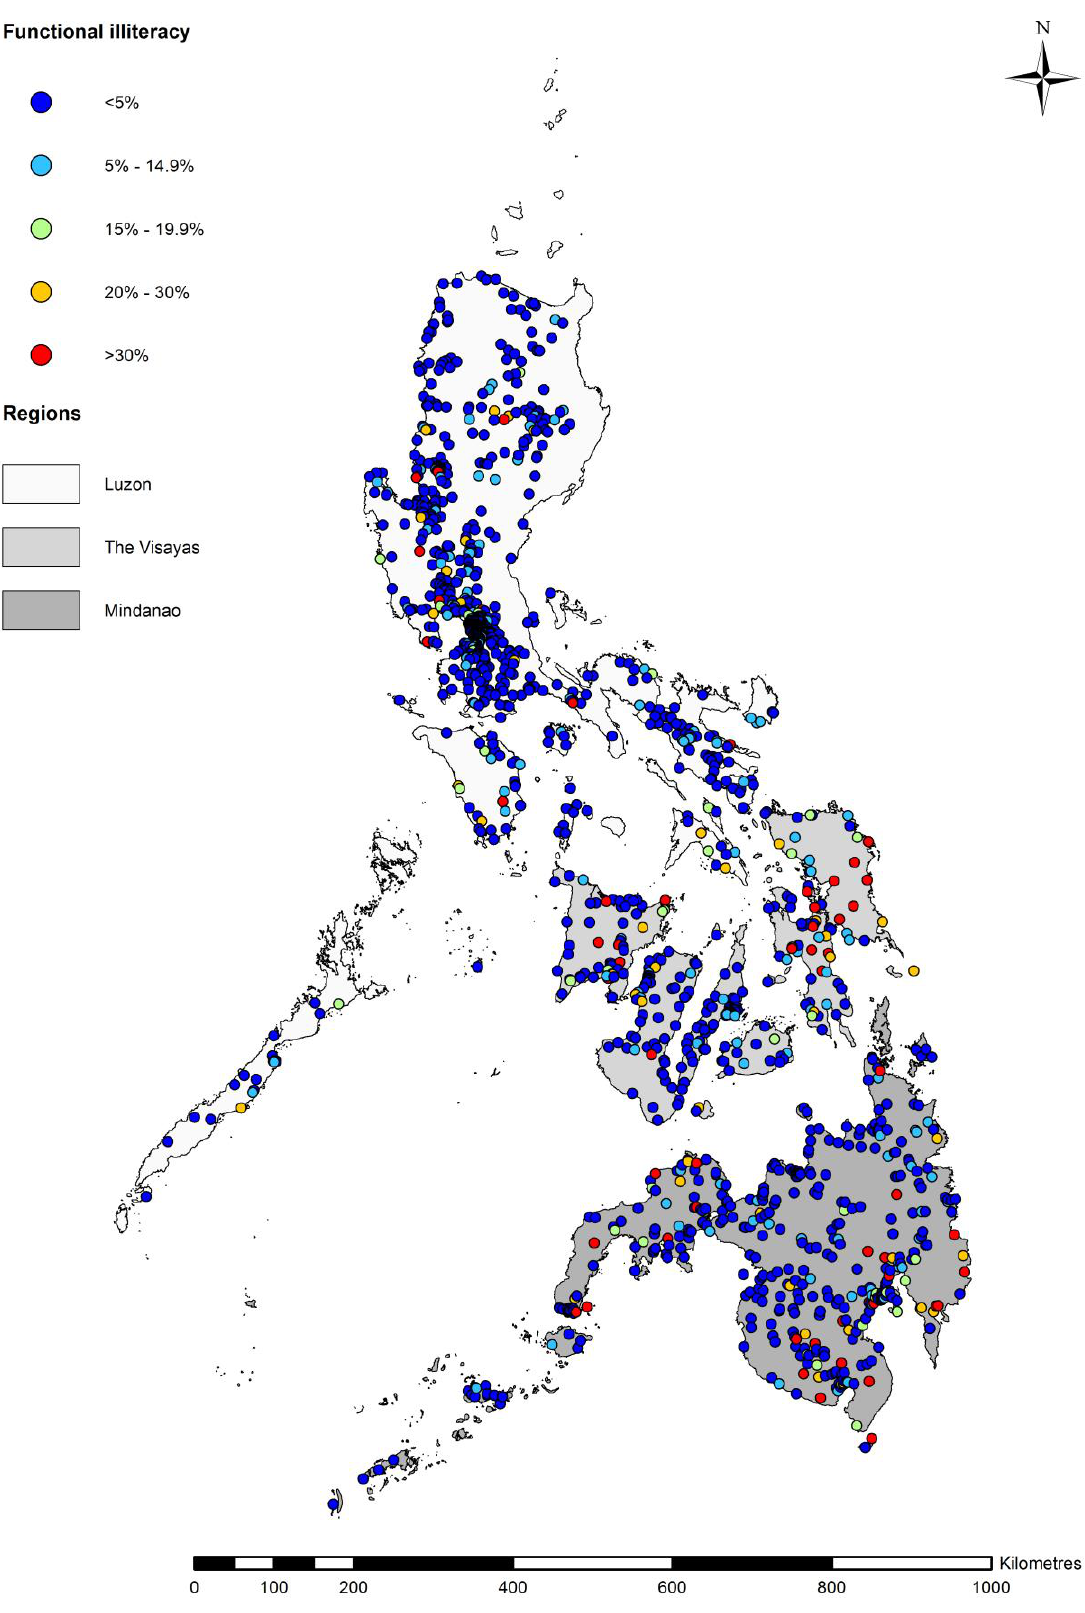
Figure 1. Map of prevalence of functional illiteracy in school-aged children.